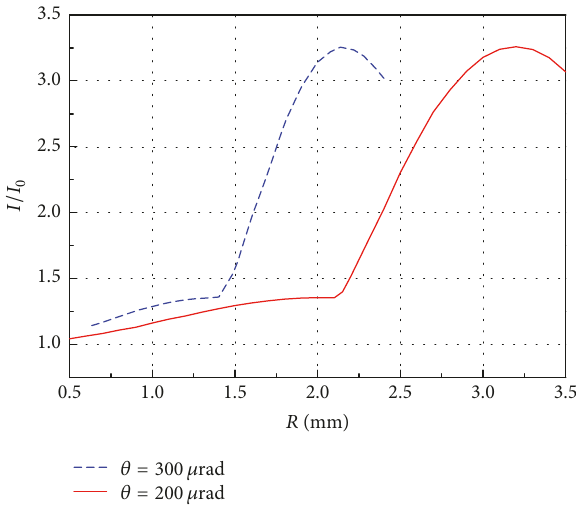
Figure 2: Intensification factor varying with increasing defect size at image relay